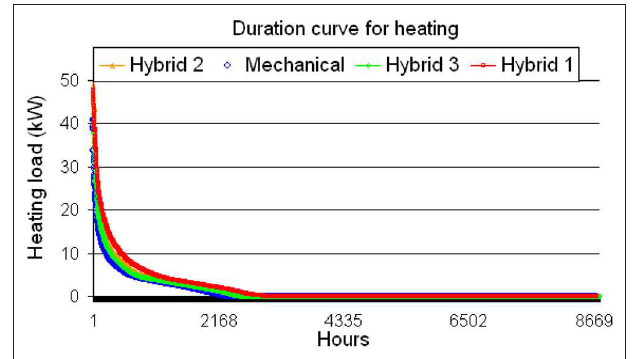
FIGURE 8 | Duration curve of the space heating power.